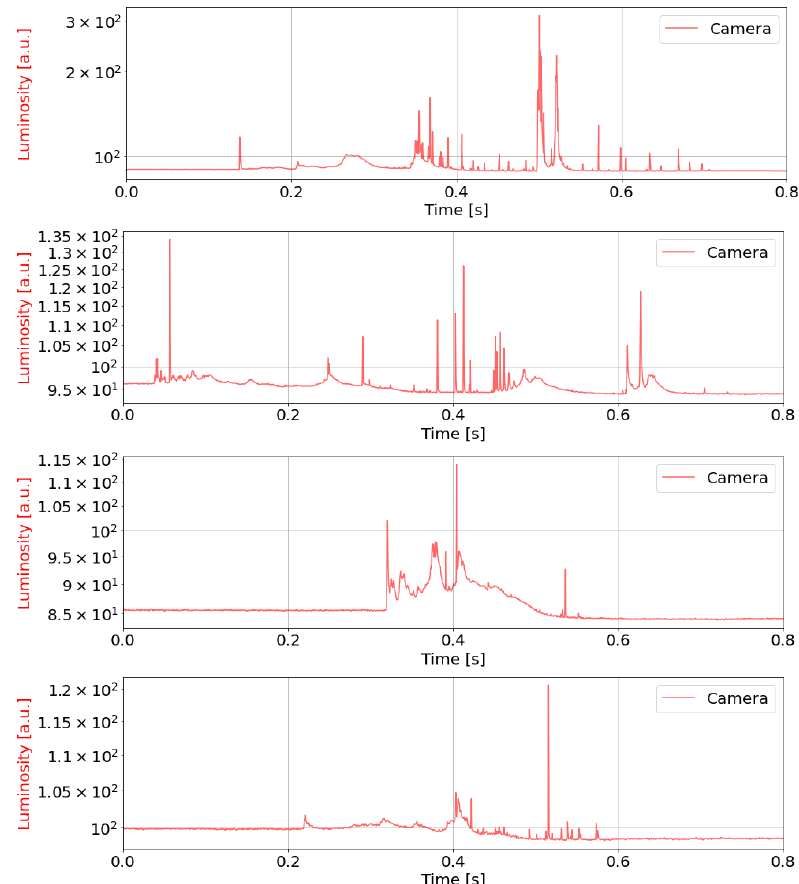
Figure 11. An example of luminosity curves for a few lightning events.